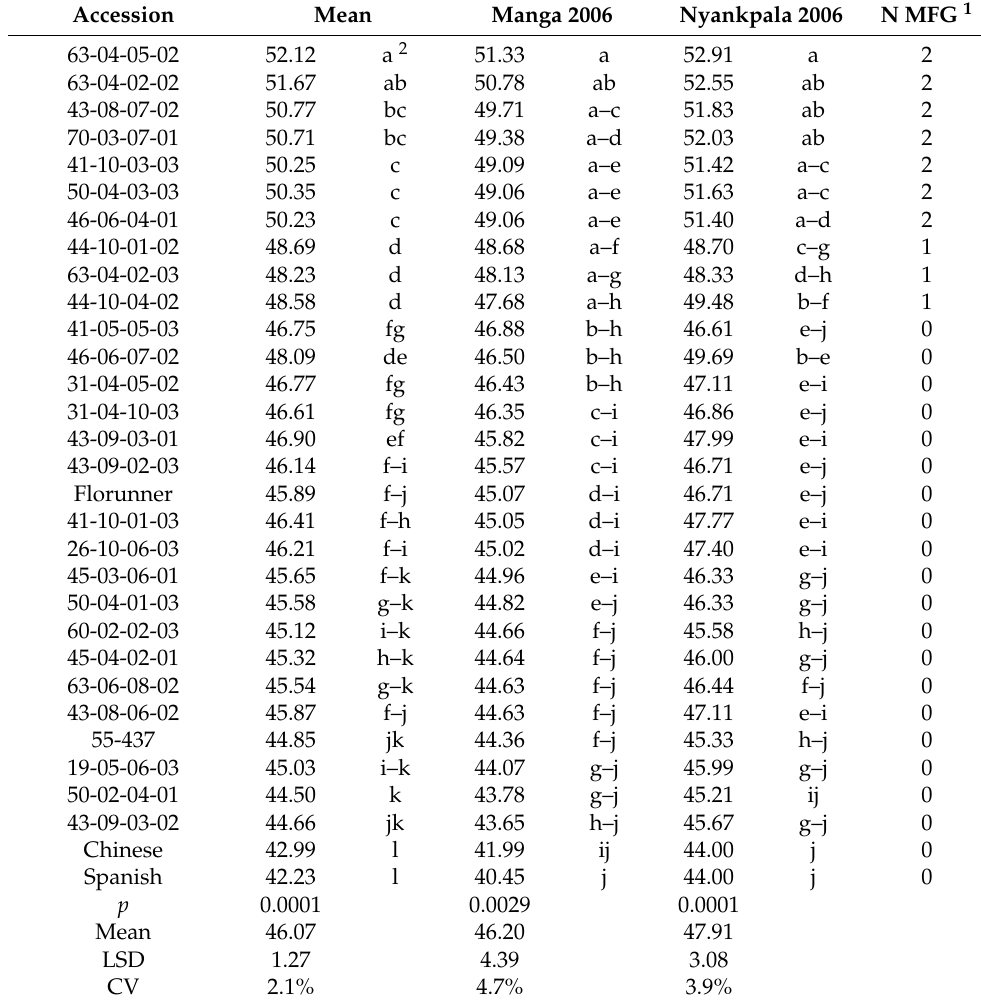
Table 4. Number of days for initial appearance of late leaf spot symptoms on 50% of